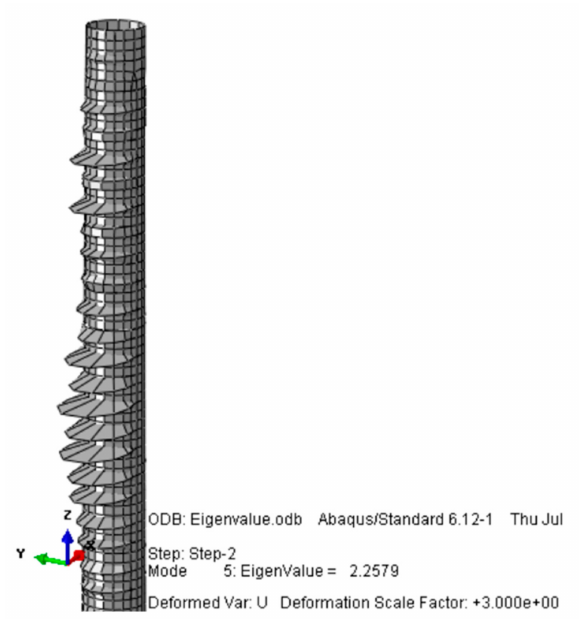
Figure 7. Tower_T_B 3rd Eigenmode.